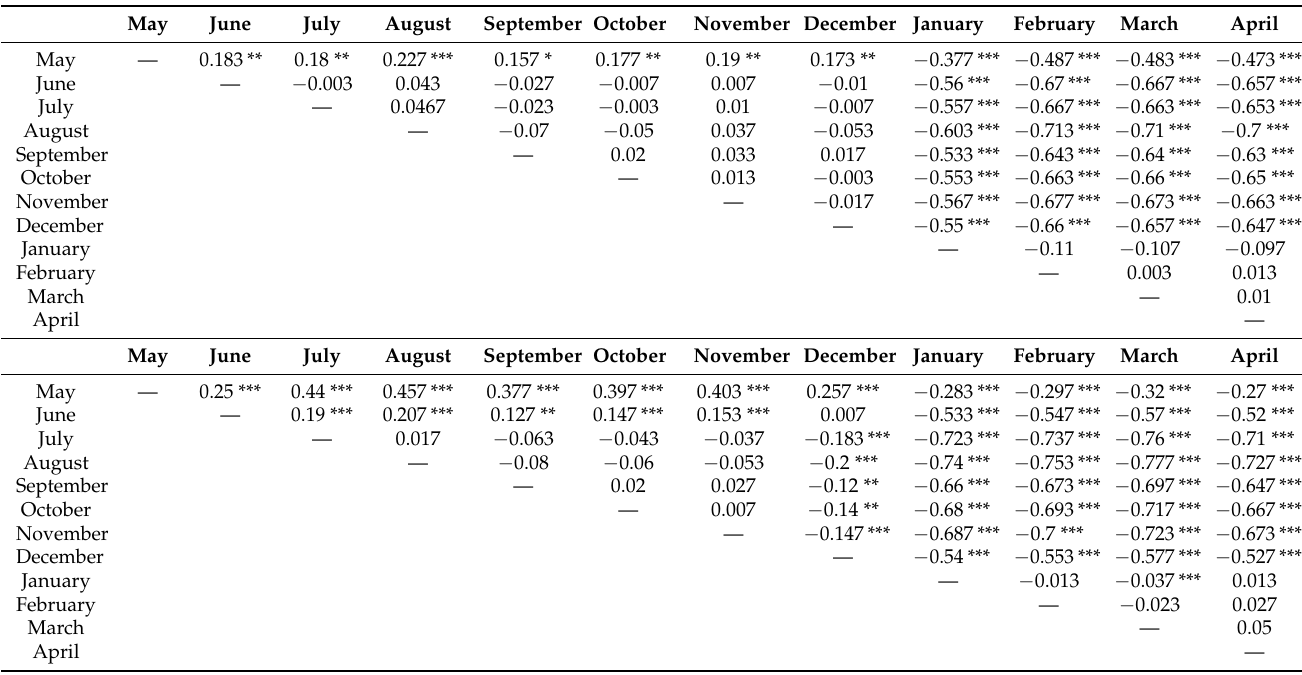
Note: Mean difference values with asterisk (*) are statistically significant different at * p < 0.05, ** p < 0.01, *** p <